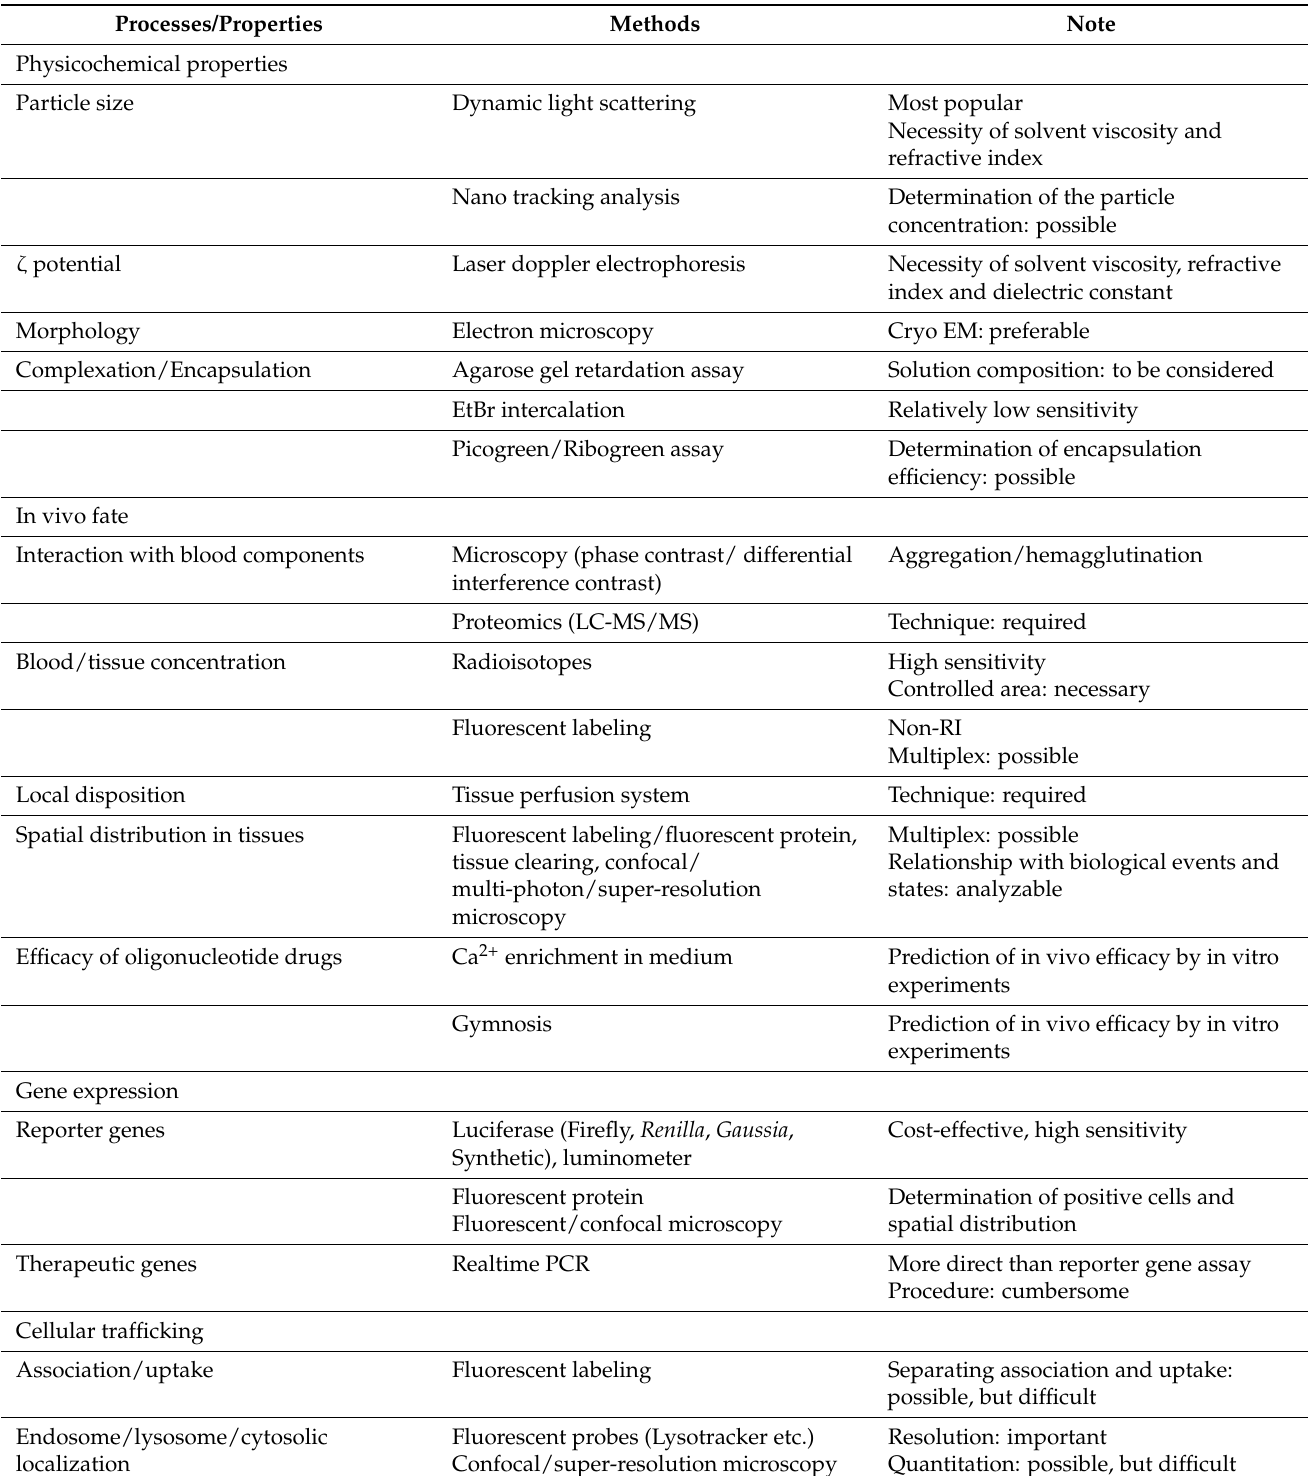
Table 1. Evaluation methods for nucleic acid and gene